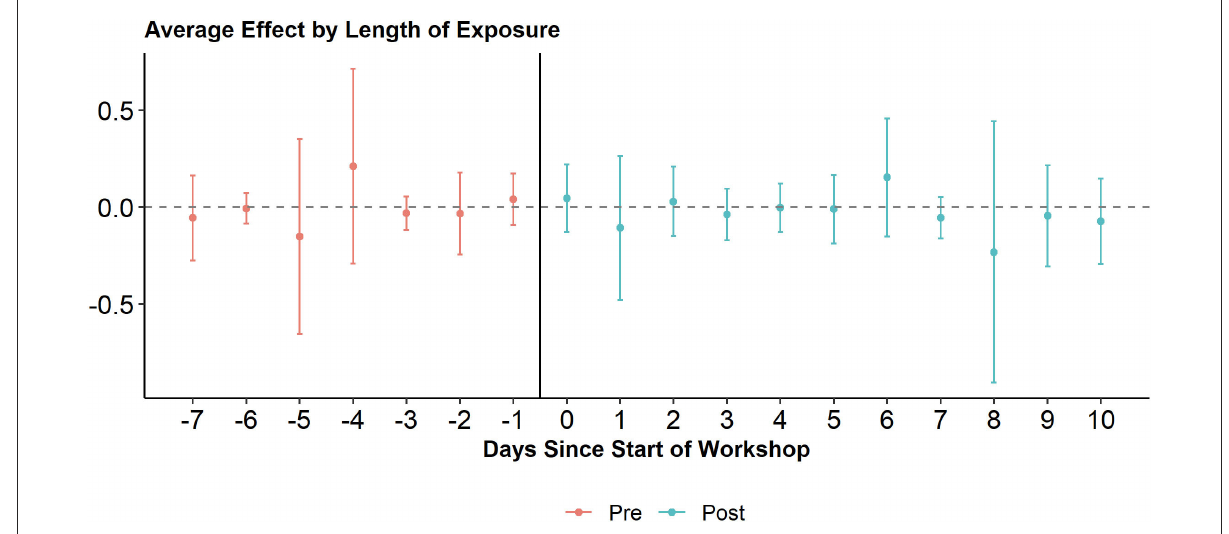
FIGURE6 Average effect of Oxfam workshop on engagement received by animators. Including 95 percent confidence interval.